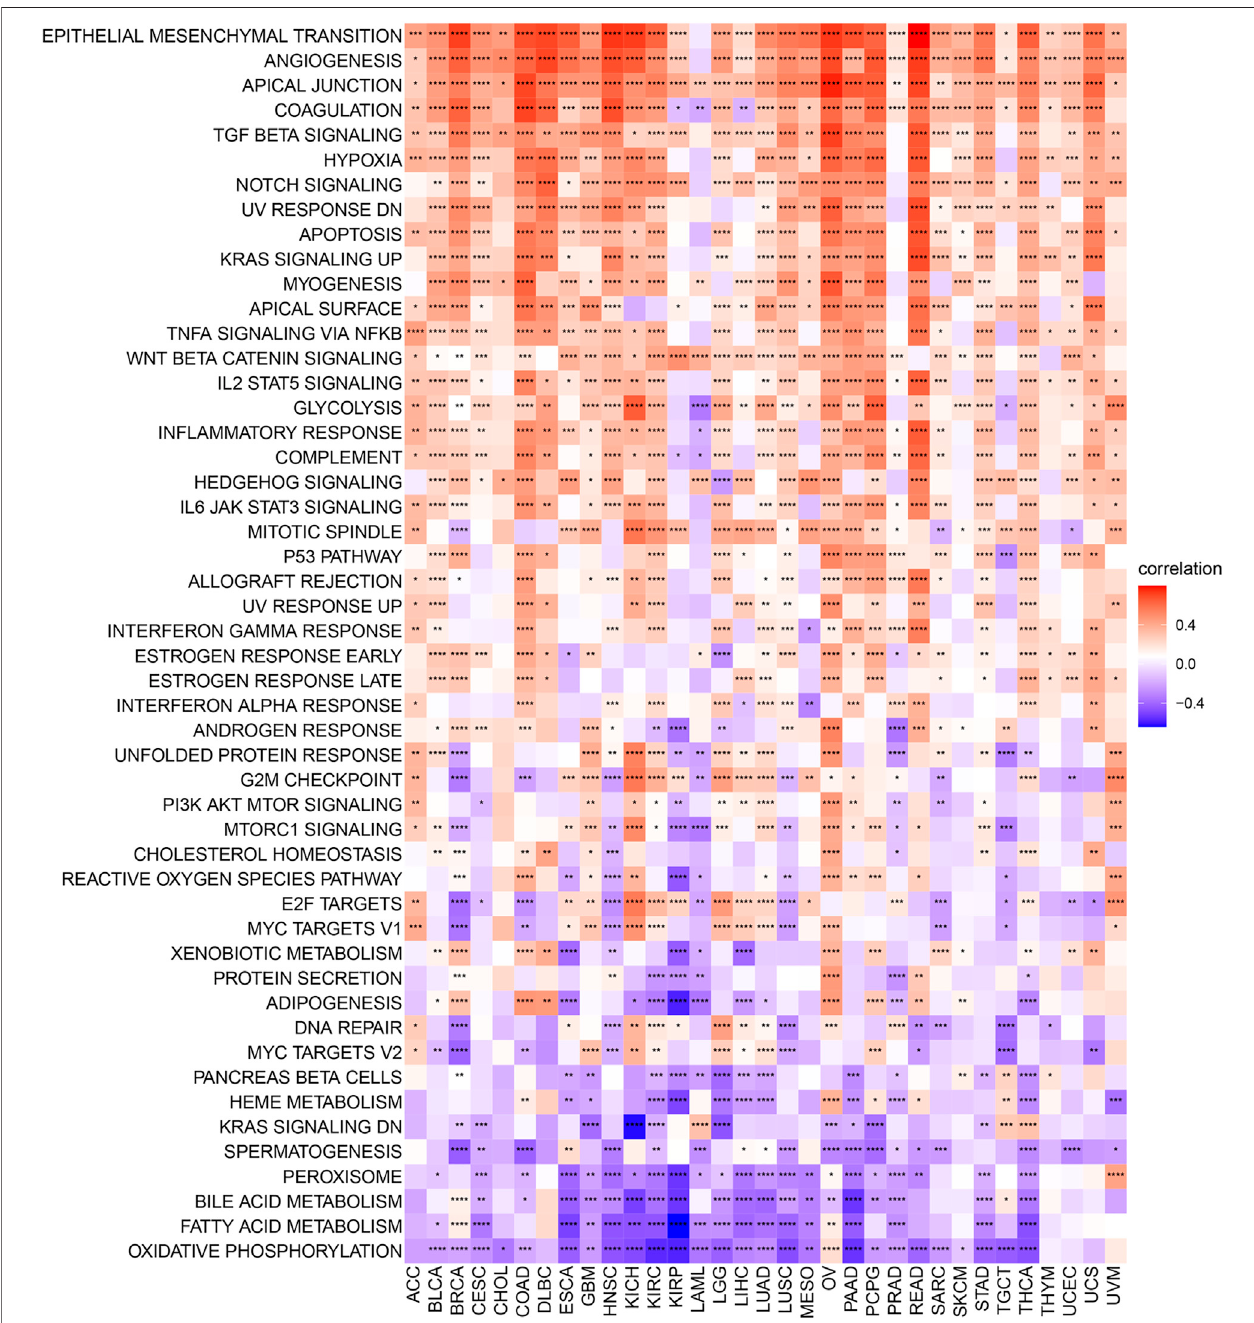
FIGURE 4 | Heatmap for different hallmark pathway enrichment scores with C1QTNF6 expression level. * p < 0.05, ** p < 0.01, *** p < 0.001, **** p < 0.0001.